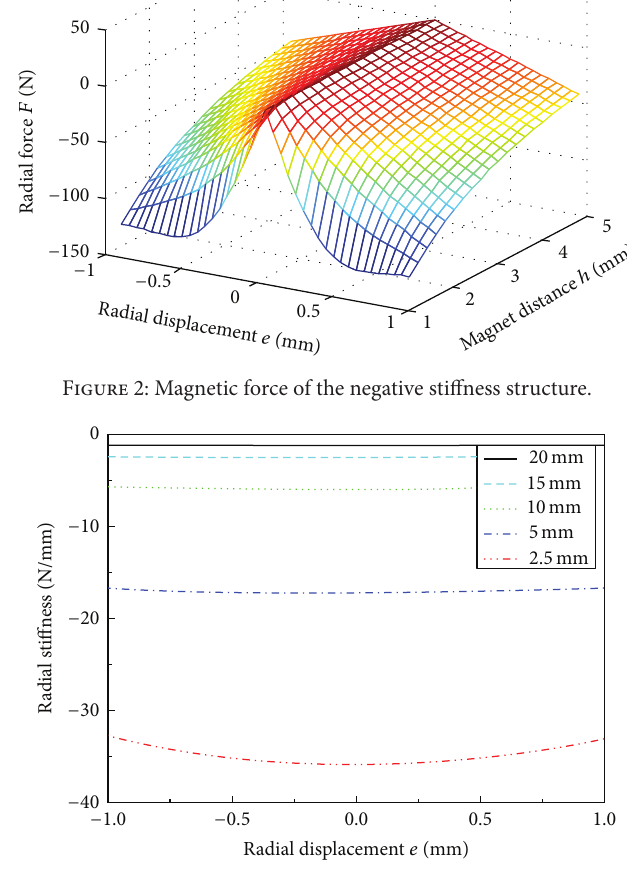
Figure 3: Stiffness of the magnetic spring when the distance is from 2.5 to